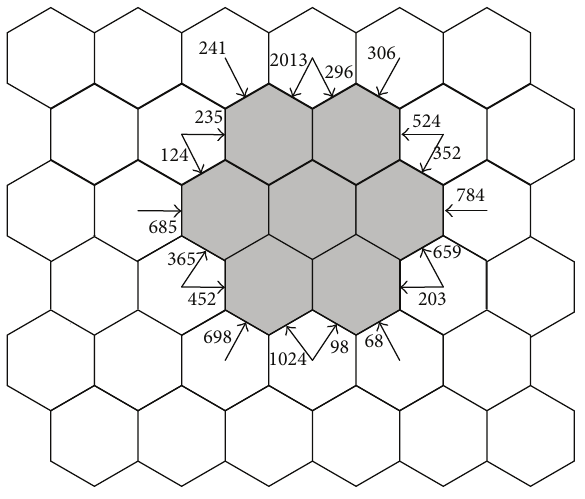
Figure 1: Entering flow of users and call arrival. Figure 2: Entering flow of users for an instant locafiguretion